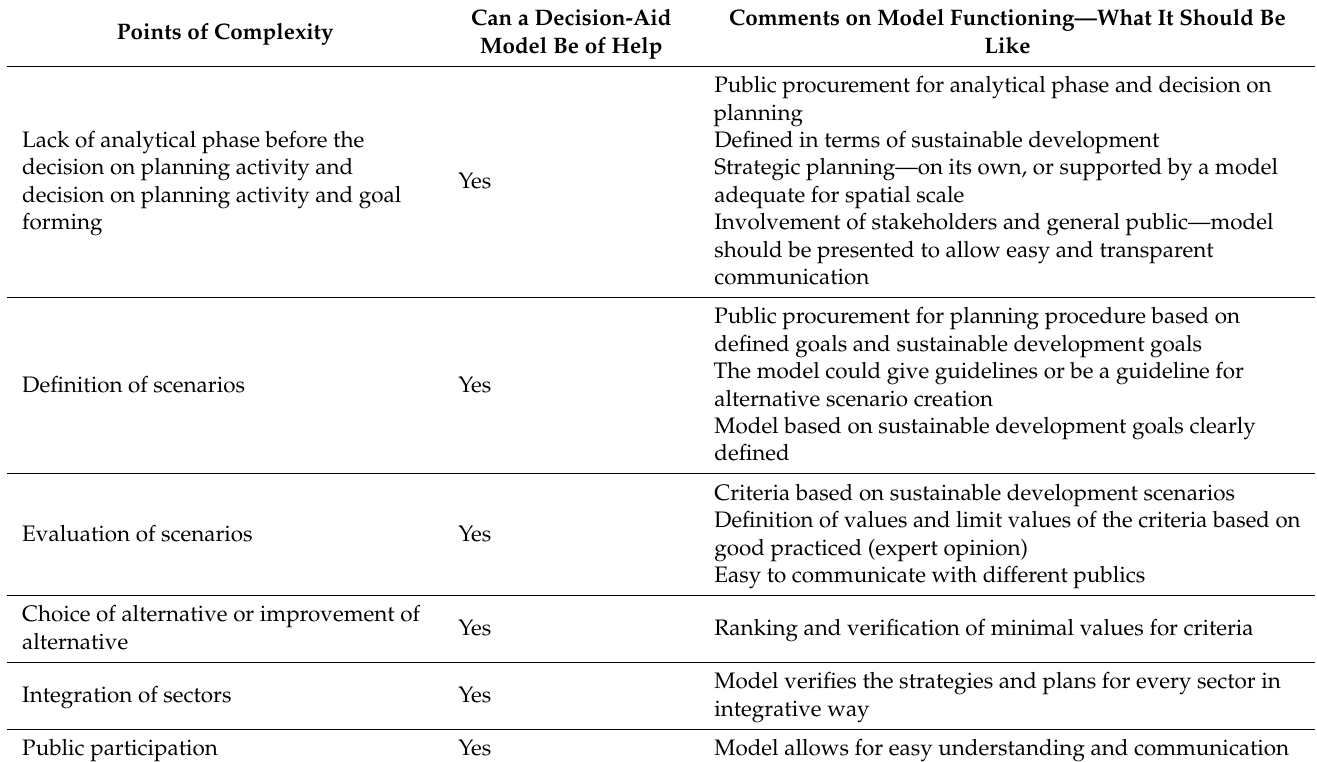
Table 1. Complexities 1, opportunities and requirements of a decision-aid model related to complexi- ties in spatial